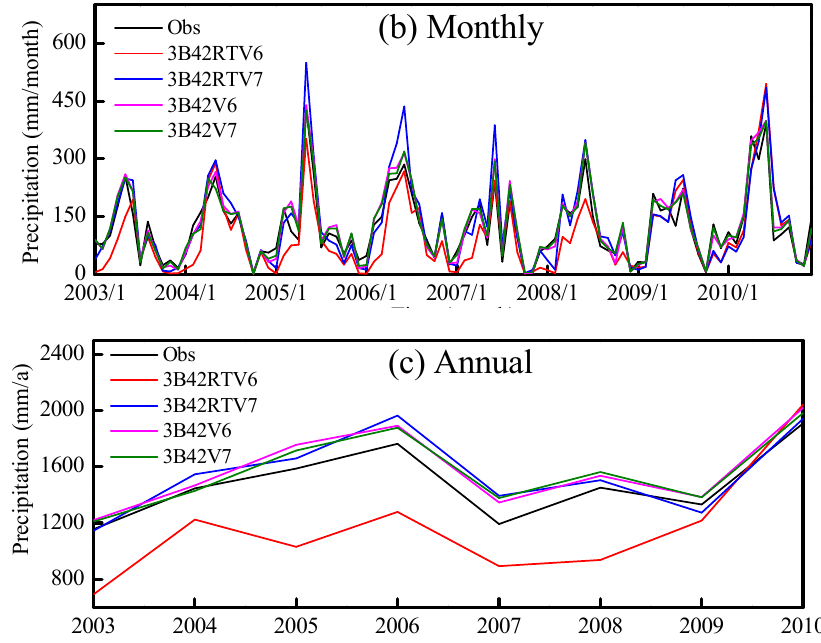
Figure 4. The precipitation time series for TMPA and observed precipitation in the Ganjiang River basin from 2003 to 2010 (( a ), Daily; ( b ), Monthly; ( c ), Annual). Table 3. The difference between the estimated precipitation of four satellite products and the observed precipitation in the Ganjiang River basin.